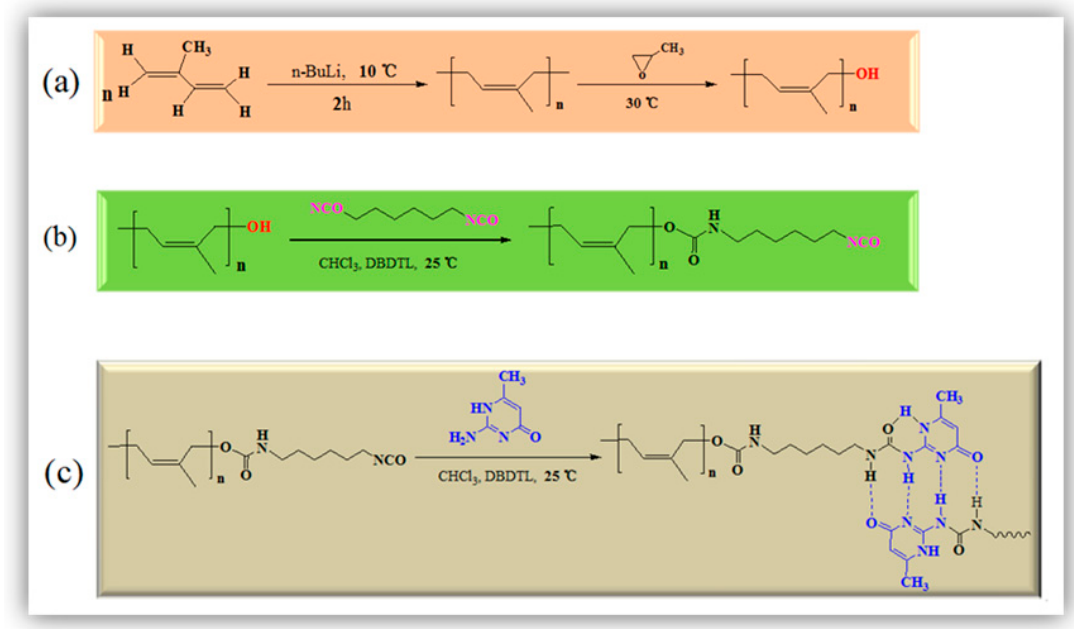
Figure 2. Synthesis of ( a ) linear hydroxyl-terminated polyisoprene (PI-OH), ( b ) isocyanate-terminated polyisoprene (PI-NCO), and ( c ) UPy-functionalized polyisoprene